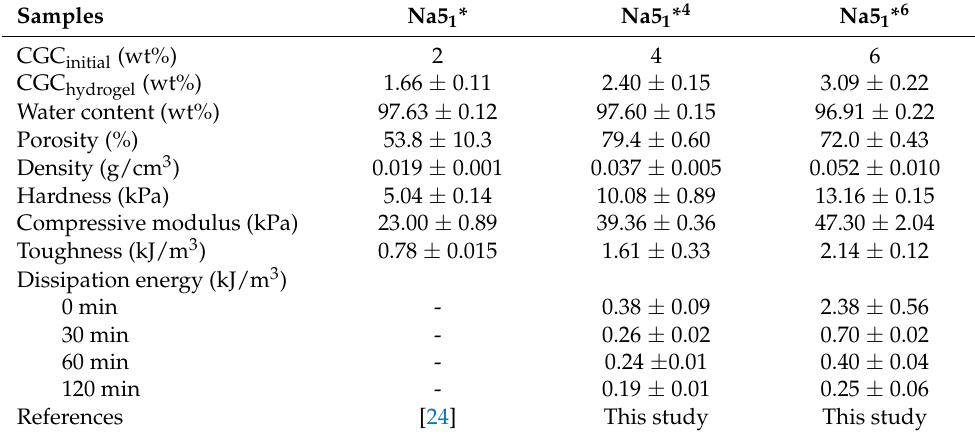
Table 1. Chemical characterization, compressive mechanical properties (under 80% strain), and dissipation energies (cycles under 50% strain) of Na5 1 * 4 and Na5 1 * 6